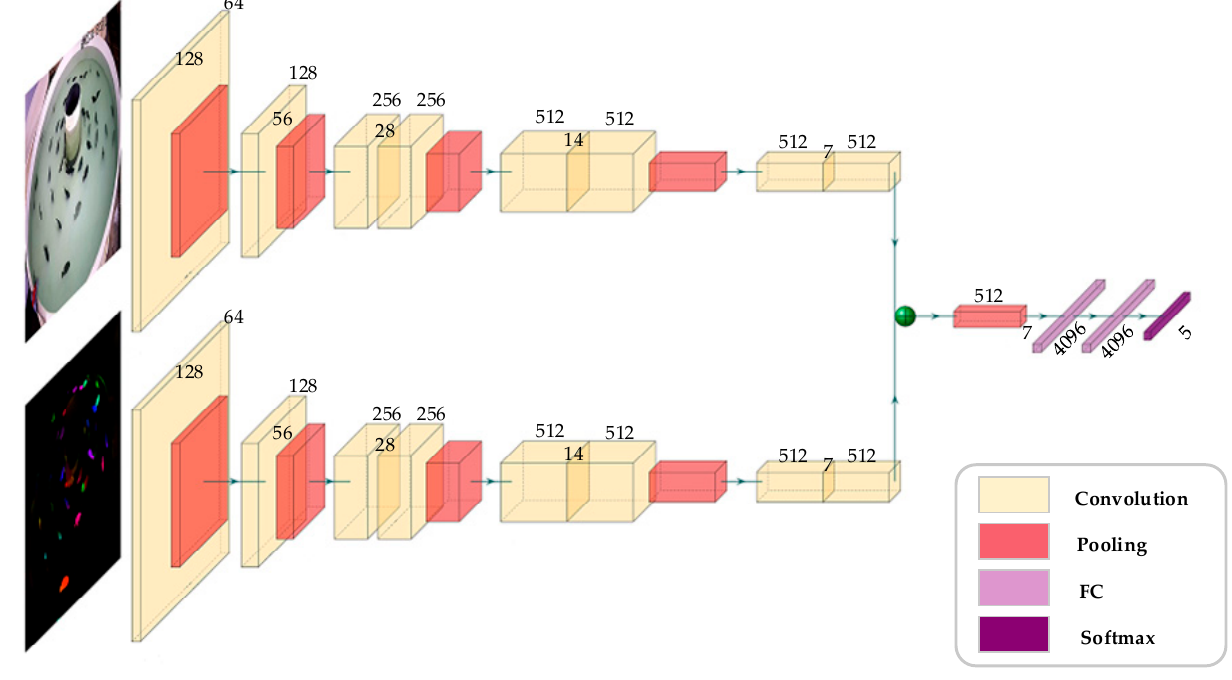
Figure 5. The network architecture of the DSC3D model with two-stream input. The original C3D network structure consists of eight convolutional layers, five pooling layers, two fully connected layers, and one softmax layer. The optimal convolution kernel size used by the eight convolution layers is 3 × 3 × 3. The numbers of convolution kernels used in each convolution layer are 64, 128, 256, 256, 512, 512, 512, and 512, respectively. In order to retain more temporal information in the initial stage of the network, the kernel size used by the first pooling layer is 1 × 2 × 2. After the convolution and pooling layer, a 4096-dim vector is generated and mapped to the predicted label after the softmax layer. The video clips are considered with a size of C × T × W × H, where C is the number of channels, T is the length of consecutive frames, W is the width of the image, and H is the height of the image. To unify the video format, we select consecutive frames with a length of 16 as the input of the model. The image size is adjusted to 1280 × 720 and then cropped to a size of 112 × 112. Since we converted the optical flow prediction result to the HSV color space, the channels of RGB video and Flow video are both 3.